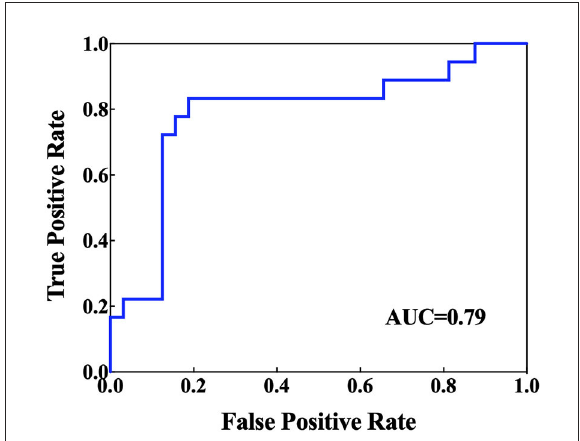
FIGURE1 Receiver operating characteristic (ROC) curves and corresponding areas under the curve (AUCs) for the brain biochemical metabolites that showed significant differences in the univariate statistical analysis.